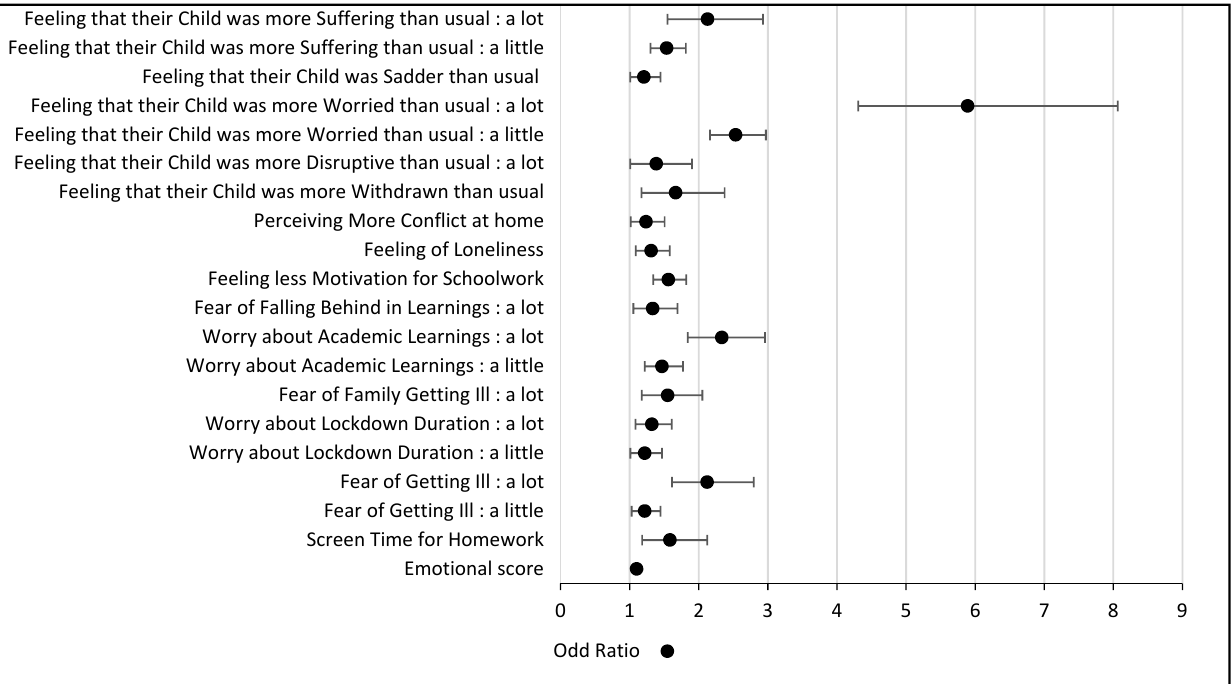
Figure 2. Risk factors significantly associated with S+.